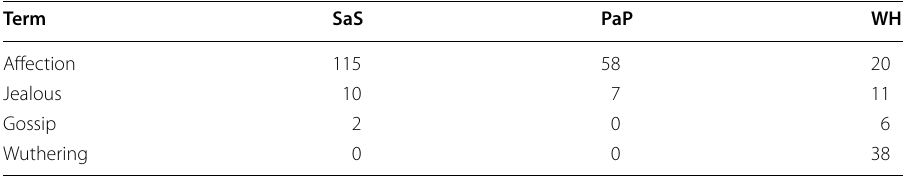
Table 1 Term frequencies of terms in each of the novels Term